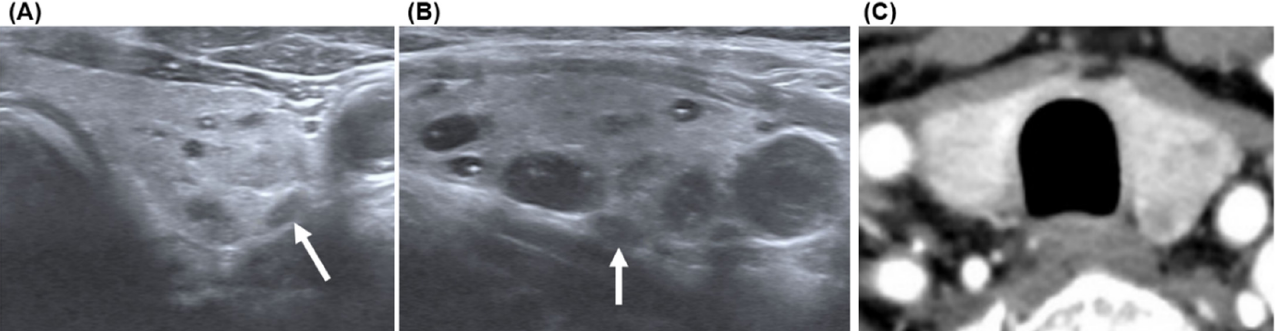
Figure 4. A 60-year-old man with secondary hyperparathyroidism. Ultrasound revealed left superior parathyroid hyperplasia (white arrow) in axial view ( A ) and in sagittal view ( B ). The left superior parathyroid hyperplasia was not seen on 4D-CT ( C ) because the parathyroid hyperplasia is small and attached to the multinodular thyroid.